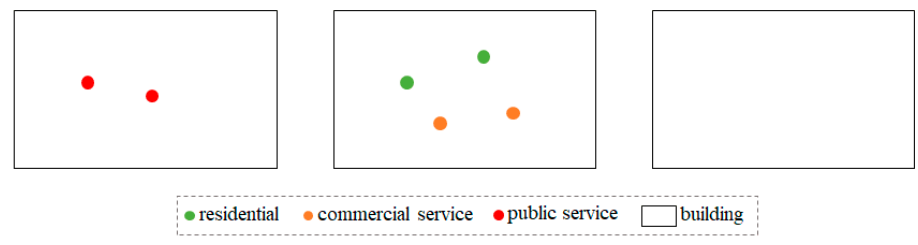
Figure 3. Spatial distribution of buildings and